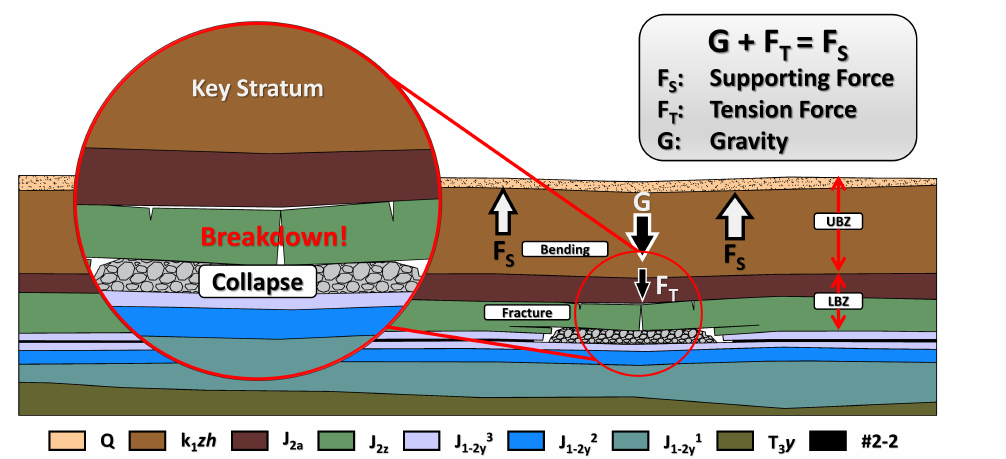
Figure 18. The unloading equilibrium of weakly cemented